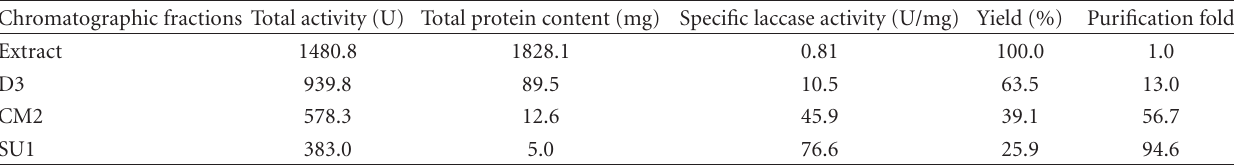
Table 1: Purification of laccase from mycelial extract of Lentinus tigrinus